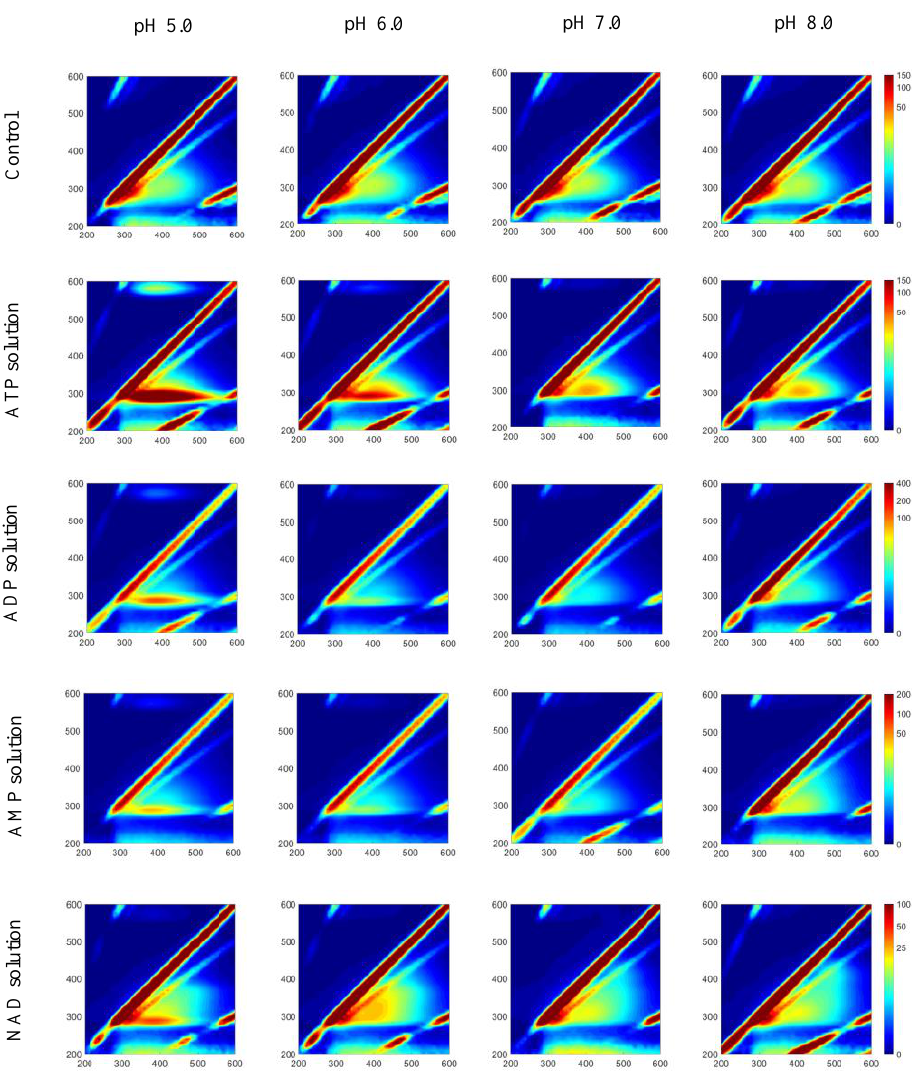
Figure 7. FF contour plots of ATP, ADP, AMP, and NAD solutions (X-axis = λ ex and Y-axis = λ em in nm).